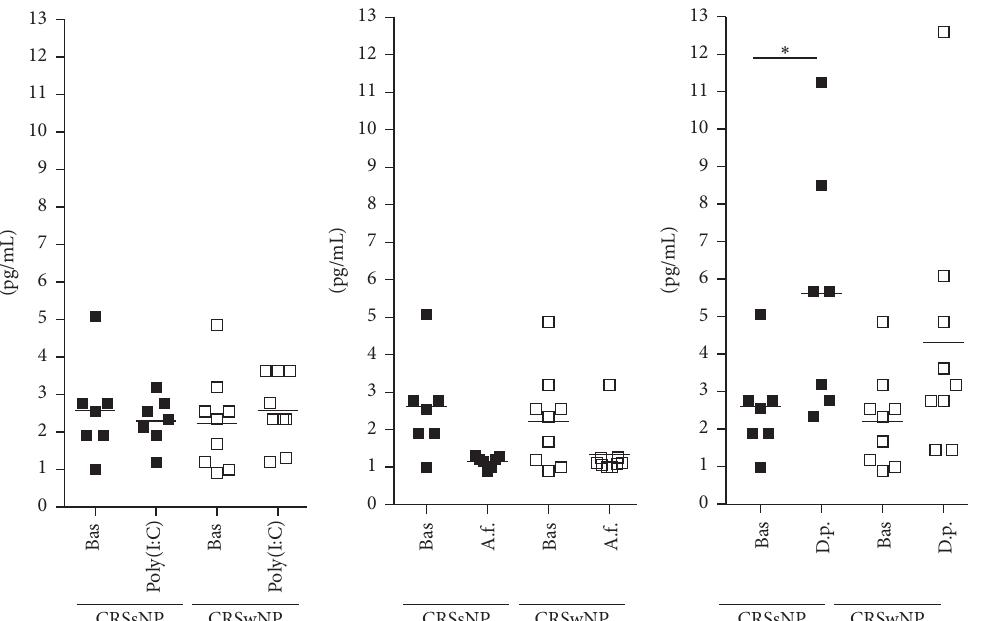
Figure3:MeanandsinglevaluesofIL-33releaseinCRSsNPandCRSwNPpatients.Bas=Baseline;A.f.= A . fumigatus ;D.p.= D . pteronyssinus . ∗ 𝑝 < 0.001 .